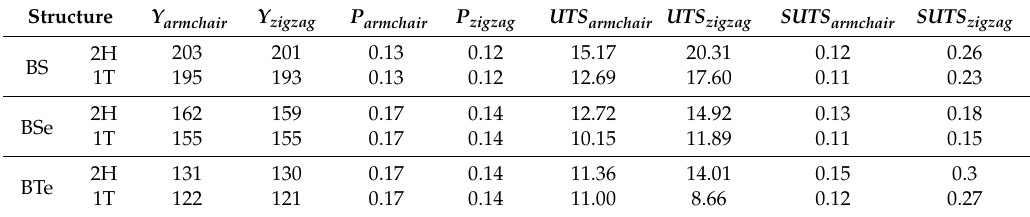
Figure 5. Uniaxial stress-strain responses of single-layer and free-standing boron monochalcogenides with 2H and 1T phases stretched along the armchair and zigzag directions. Table 2. Mechanical properties of single-layer BS, BSe and BTe with 2H and 1T atomic lattices along the armchair and zigzag directions. Y , P , UTS and SUTS stand for elastic modulus, Poisson’s ratio, ultimate tensile strength, and strain at ultimate tensile strength point, respectively. Stress units are in N/m.